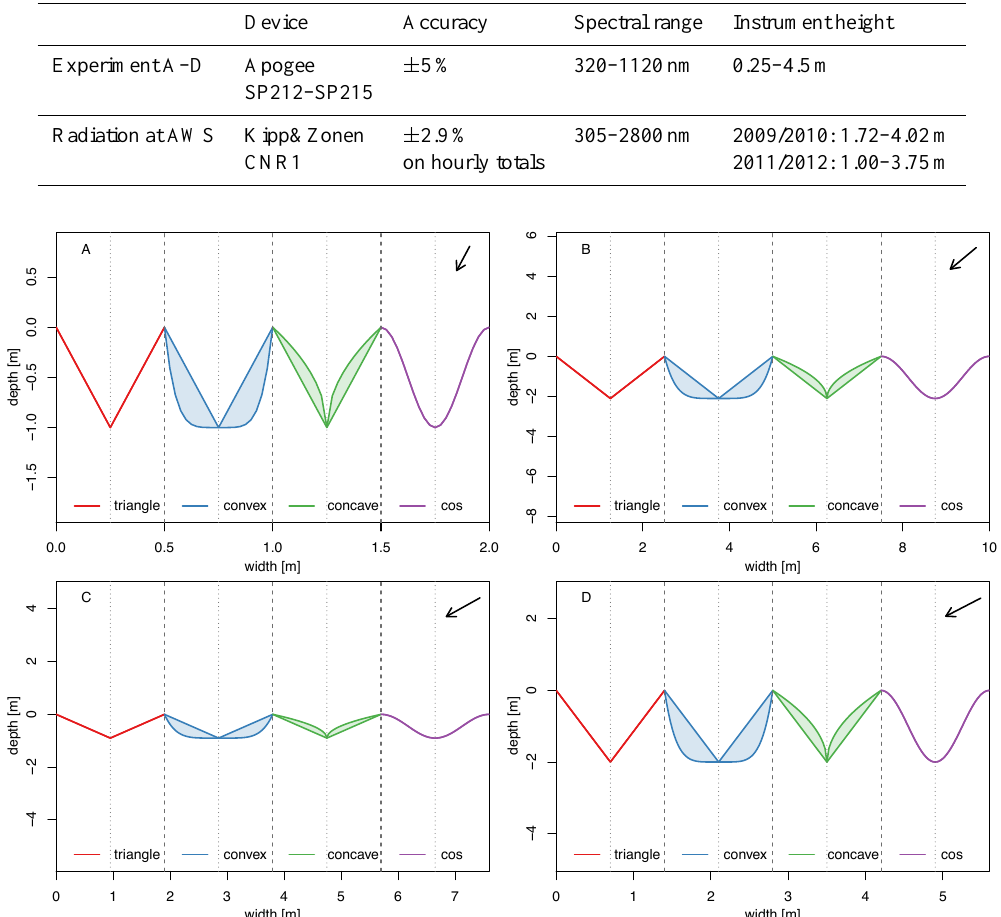
Figure 4. The different penitente shapes used in the ISRT model based on the equations in Table 3. The blue/green shaded areas for the convex/concave shapes represent the variability in shapes due to the uniform distributions U( min , max ) in Table 3. The dotted/dashed grey lines indicate the position of the penitente trough/tip, whereas the arrows illustrate the angle of direct incoming radiation during experiments A–D. Note the different y